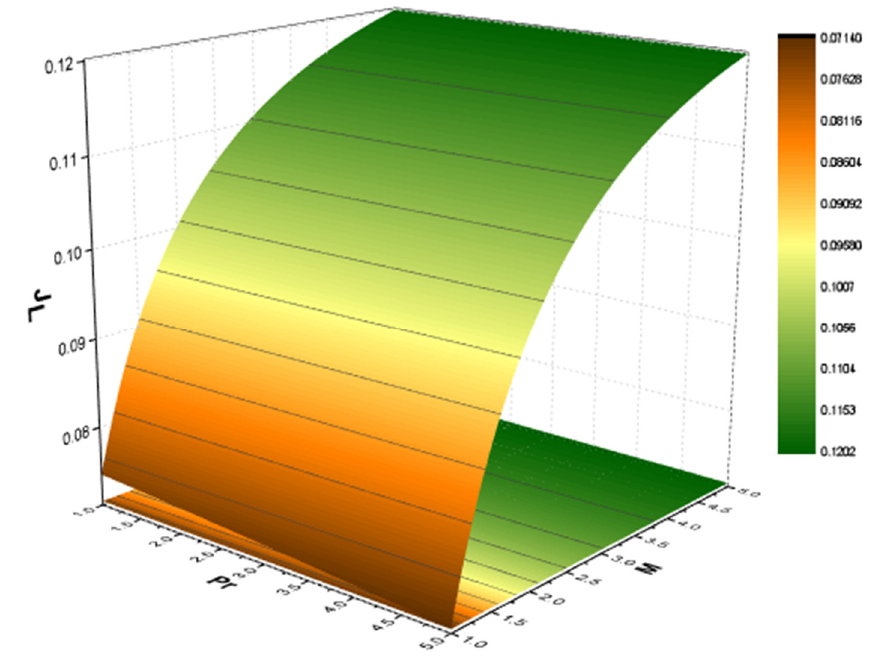
Figure 18. Impact of Pr and M on LDC.